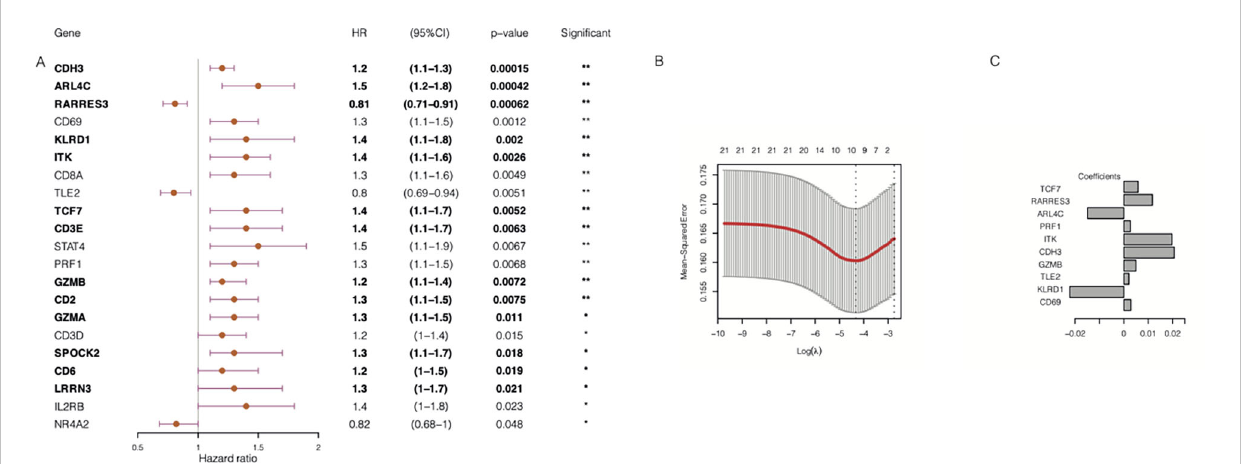
FIGURE 6 Construction of chemoresistance-associated TILCD8TSig (cr-TILCD8TSig). (A) Univariate Cox regression analysis results of 21 genes involved in TILCD8TSig (Bold fonts indicates the 13 genes with signi fi cant prognostic value based on Kaplan-Meier analysis.) (B) Lasso analysis revealed 10 genes that were signi fi cantly prognostically characteristic. (C) Coef fi cient of the 10 genes. Values were considered statistically signi fi cant at p<0.05 (*, p<0.05; **,